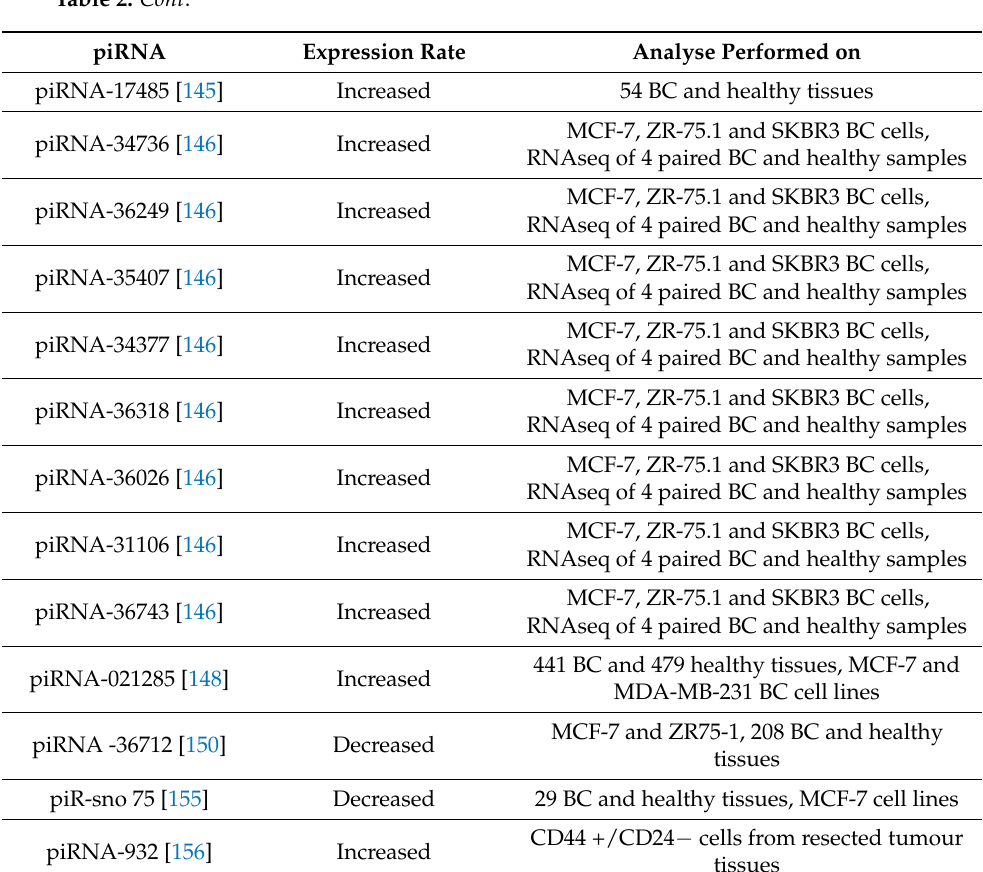
Table 2. List of abnormally expressed piRNAs in BC cell lines and tissues. piRNA Expression Rate Analyse Performed on piRNA-651 [141] Increased FFPE samples of BC tumours, BCaP cell lines piRNA-4987 [145] Increased 54 BC and healthy tissues piRNA-19825 [145] Increased 54 BC and healthy tissues piRNA-20365 [145] Increased 54 BC and healthy tissues piRNA-20485 [145] Increased 54 BC and healthy tissues piRNA-20582 [145] Increased 54 BC and healthy tissues